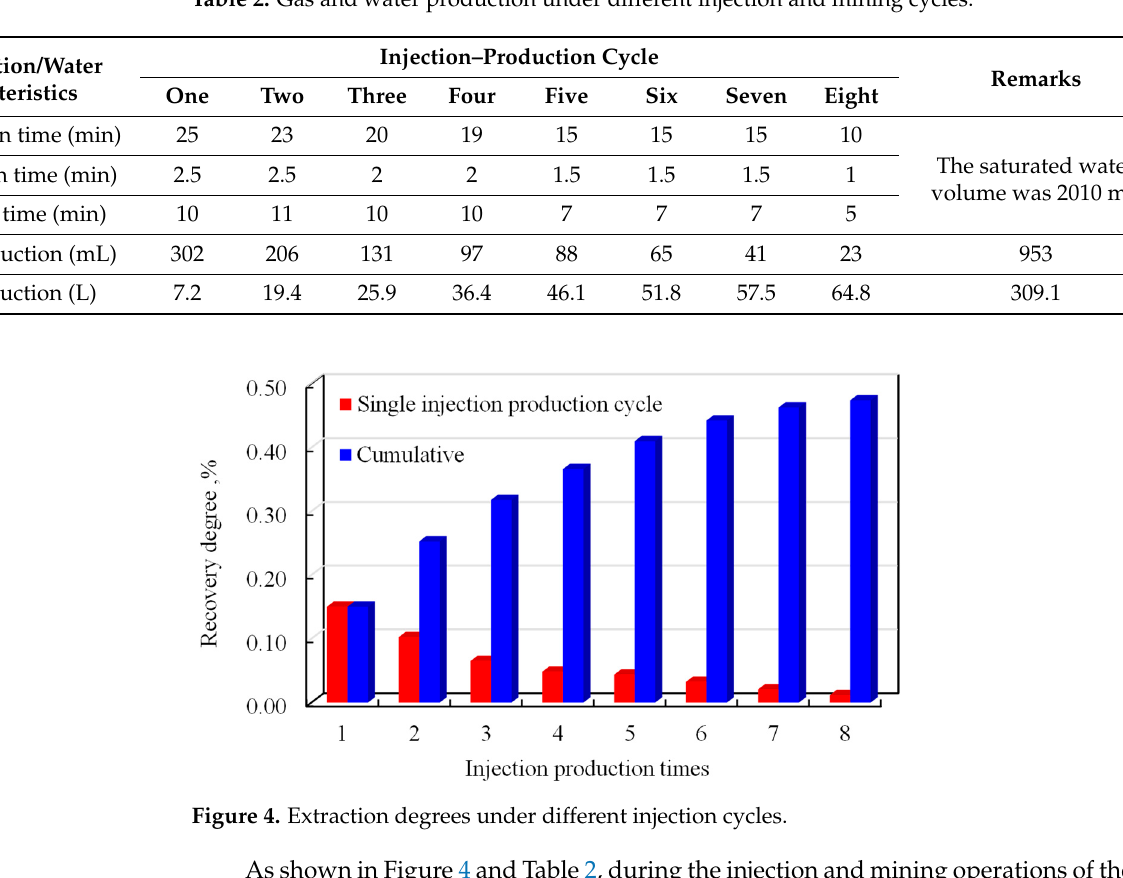
Table 2. Gas and water production under different injection and mining cycles.